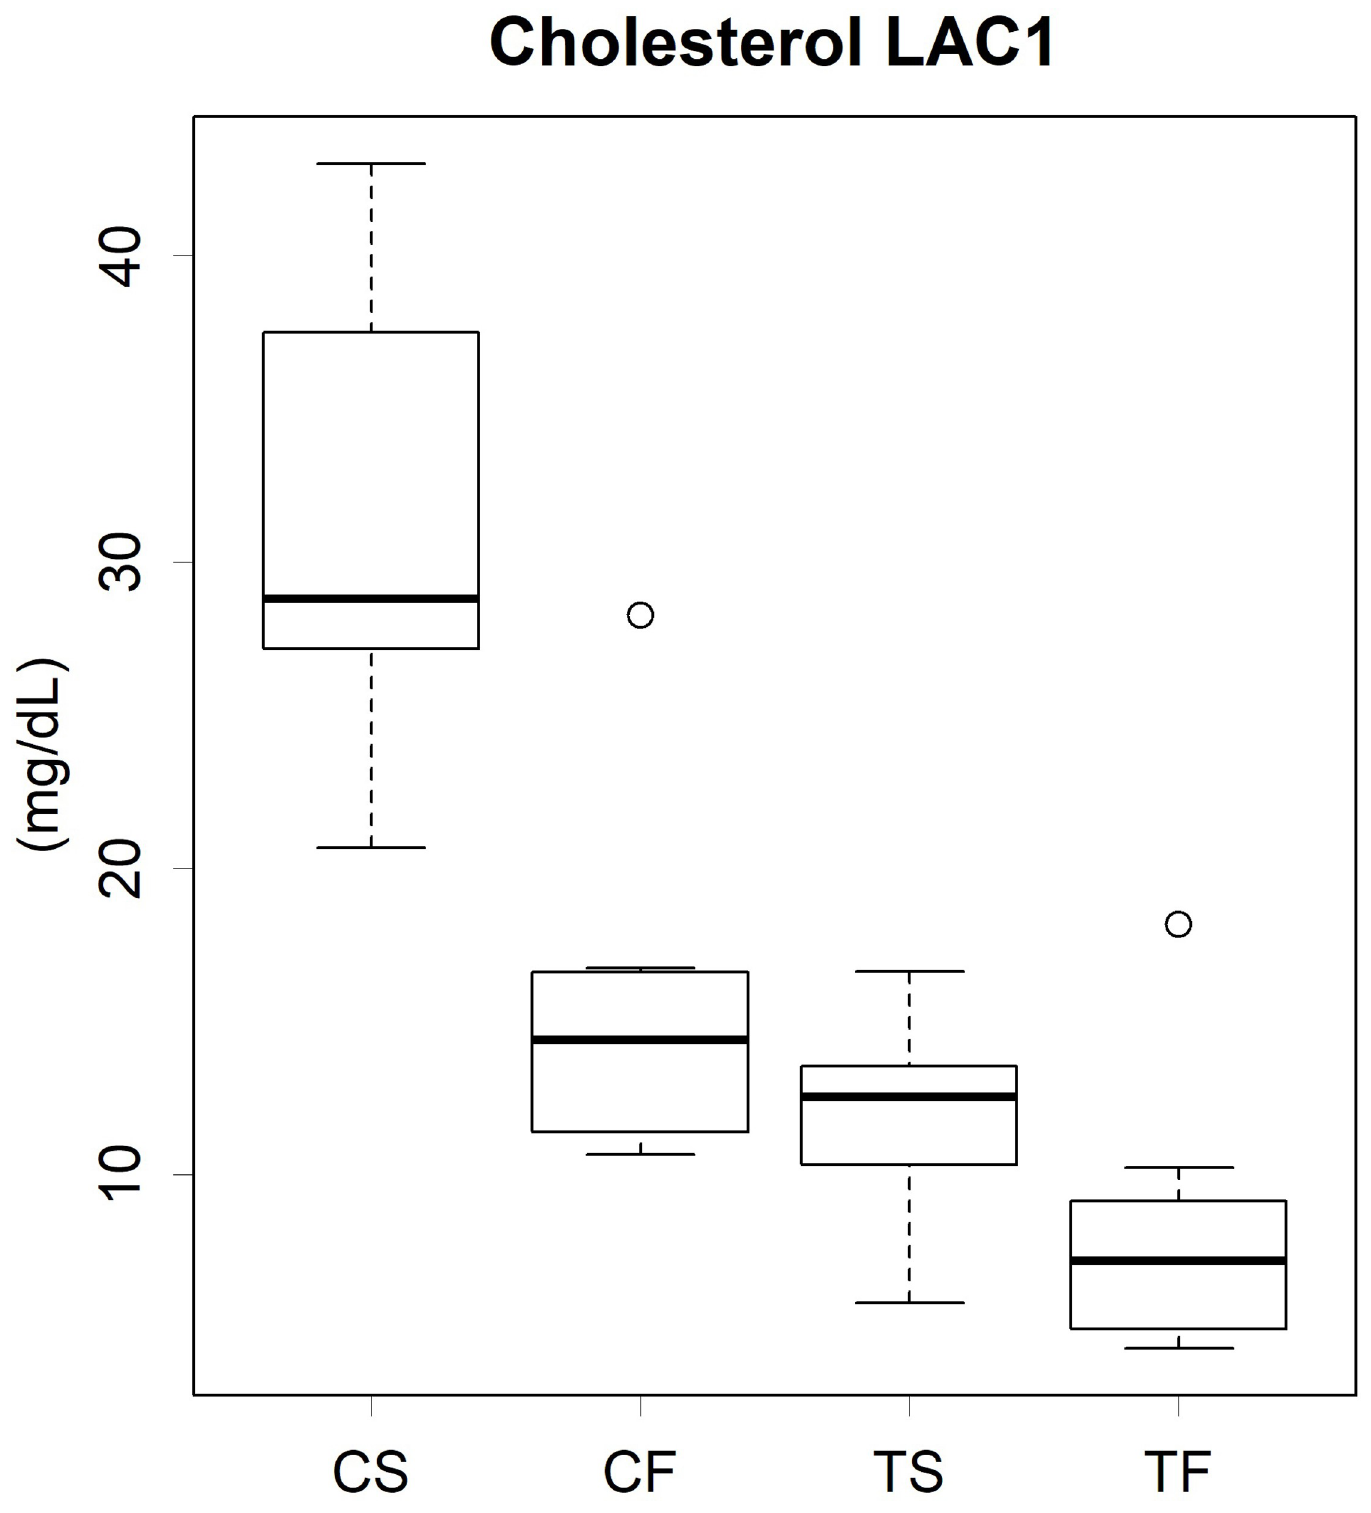
Fig 6. Cholesterol level of the lipoprotein class LAC1. C, Casein; T, tofu; S, soy oil; F, fish oil. The bottom and top of the box are the first and third quartiles, respectively, and the band inside the box indicates the second quartile. Small circles show outliers. Results of statistical analyses are presented in S1 Appendix.